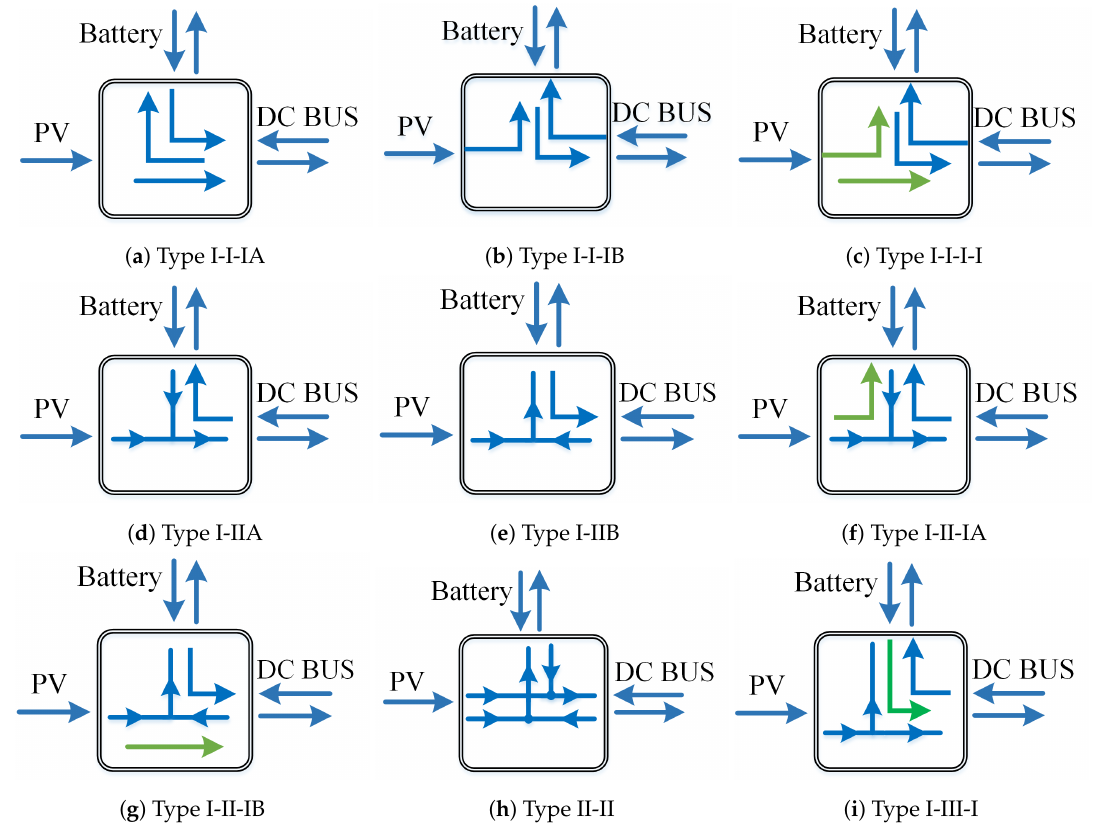
Figure 4. All possible power flow graphs of three-port configurations. ( a ) Battery to DC bus, DC bus to battery and PV to DC bus. ( b ) Battery to DC bus, DC bus to battery and PV to battery. ( c ) Battery to DC bus, DC bus to battery, PV to DC bus and PV to battery. ( d ) PV and battery to DC bus + DC bus to battery. ( e ) PV and DC bus to battery + battery to DC bus. ( f ) PV to battery path added to ( d ). ( g ) PV to DC bus path added to ( e ). ( h ) Mixture of 2 of Type I and Type III configurations. ( i ) Mixture of 2 of Type II